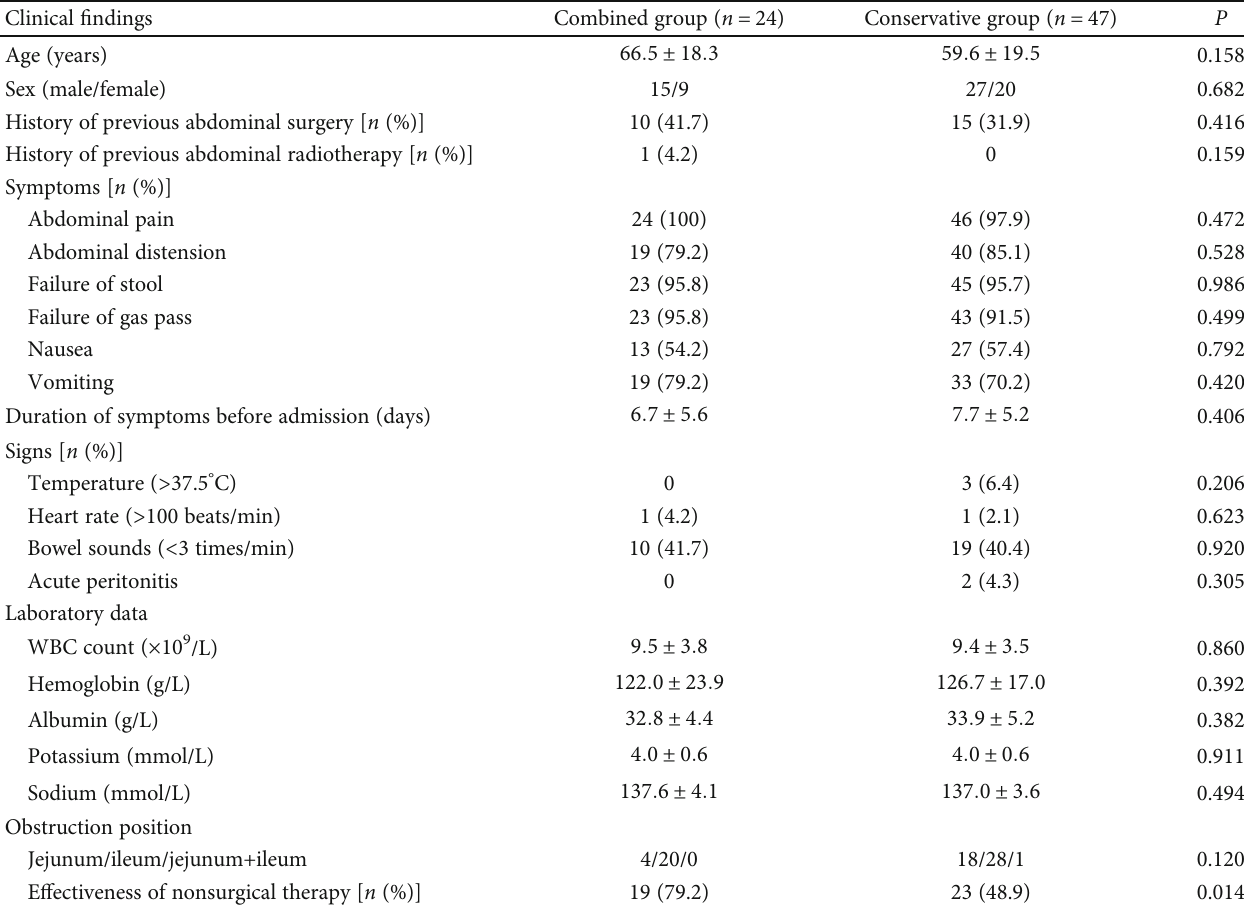
Table 1: Clinical fi ndings of the combined and conservative